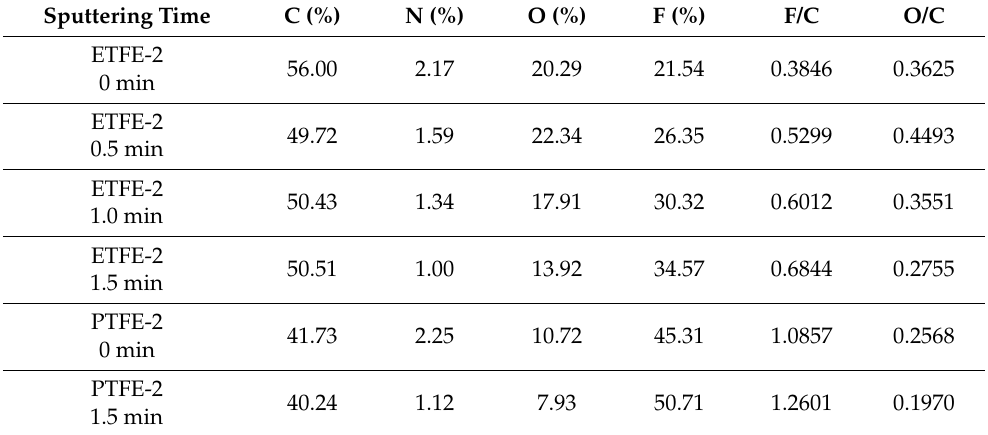
Table 3. Analysis of elemental content of ETFE-2 and PTFE-2 membranes as a function of sputtering